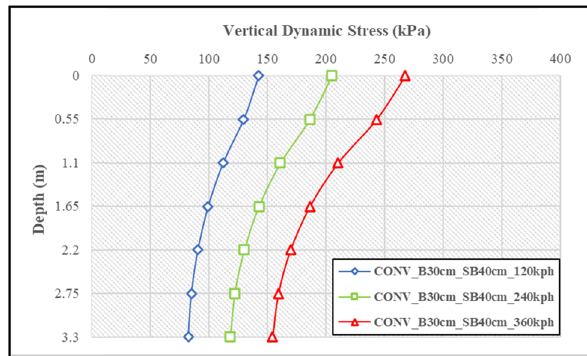
Figure 6: Vertical compressive stress curve in subgrade layer of Indonesia ’ s ballasted track at 120, 240, and 360 kph train speed.